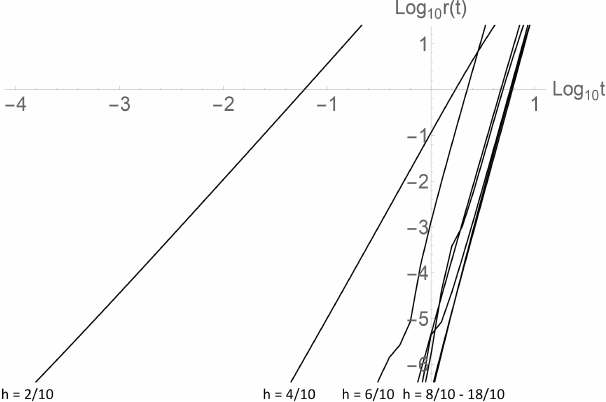
Figure A1. This shows the logarithm of the relative error in (t) approximation (i.e. with 10 fractional terms and the R ( 10 , 10 ) 0 ,h 10 integer-ordered terms) with respect to the deviation from (cid:12) (cid:0) R fGn (t) − R ( 10 , 10 ) (t) (cid:1)(cid:14)(cid:0) R fGn (t) − the fGn R 0 ,h (t) r = log 10 (cid:12) 1 − h h 0 ,h (cid:1)(cid:12) R 0 ,h (t) (cid:12) . The lines are for h = 2 / 10, 4 / 10, ..., 16 / 10, 18 / 10 (ex- cluding the exponential case h = 1), from left to right (note that convergence is only for irrational h , and therefore an extra 10 − 4 was added to each h ). For the low h values the convergence is par- ticularly